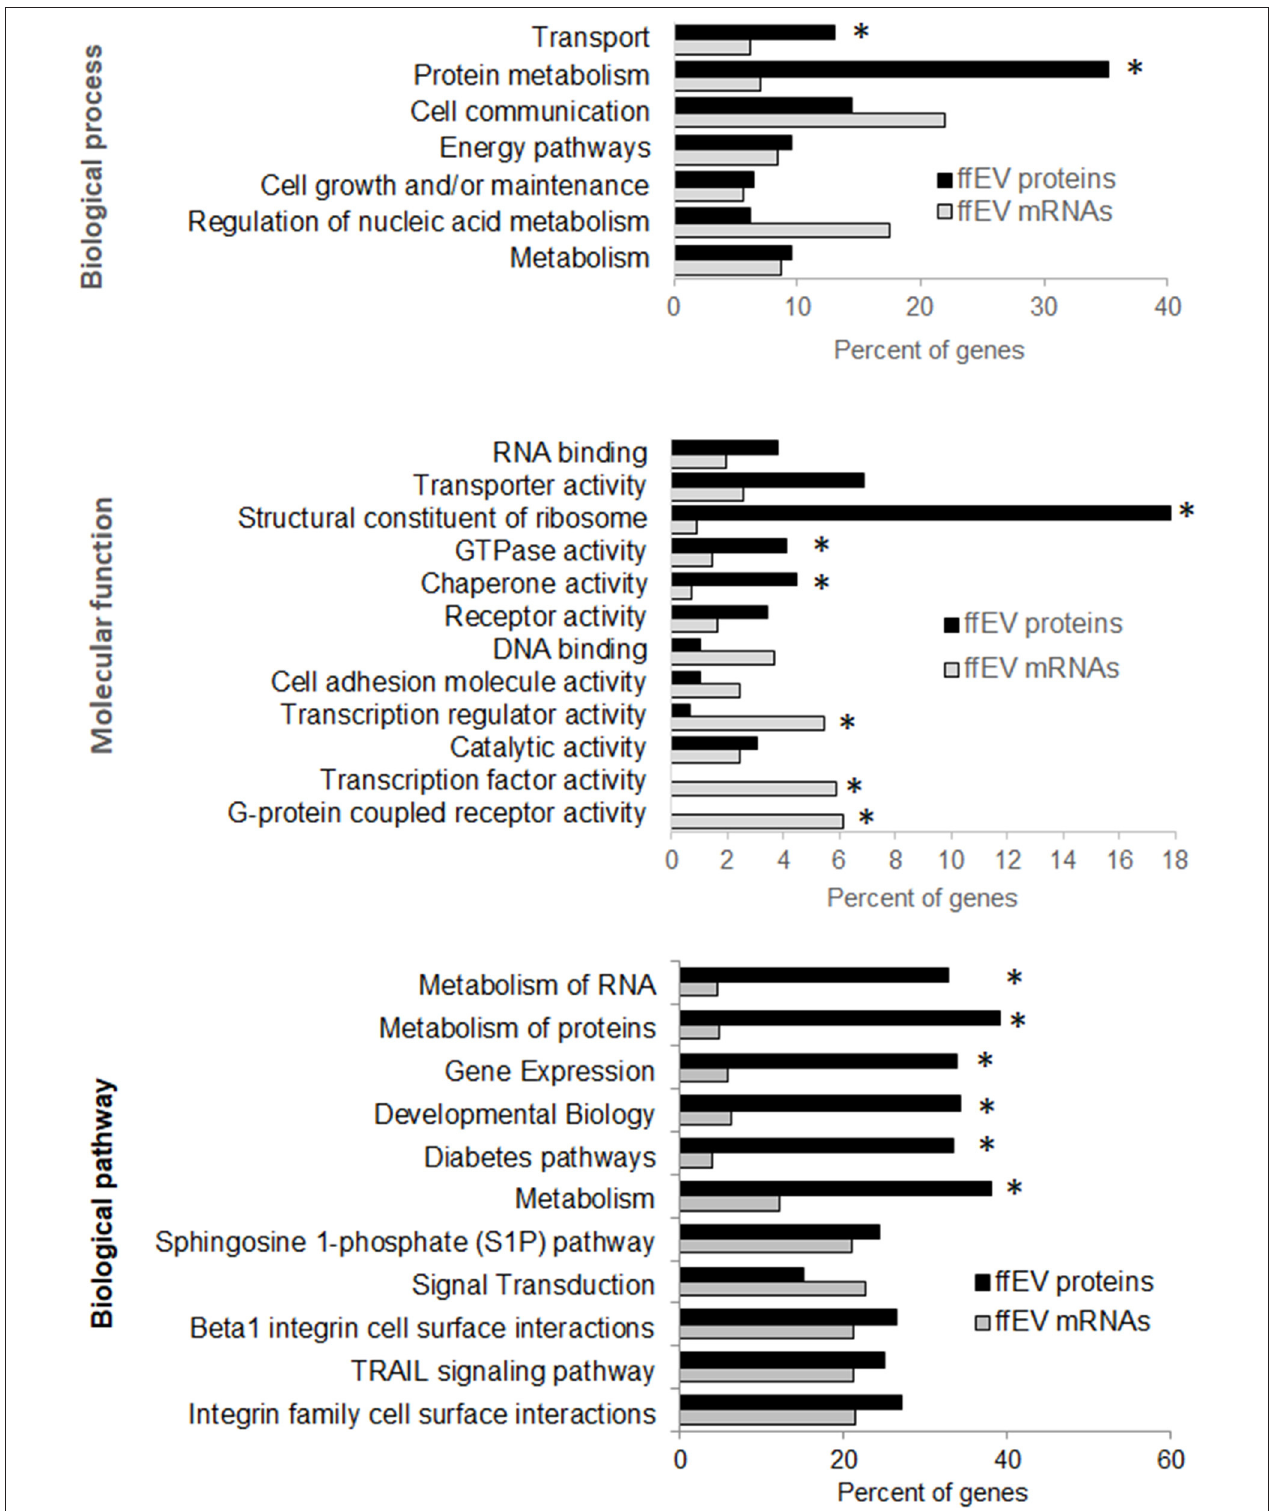
FIGURE 5 | Comparative analysis of Gene Ontology (GO) enrichment terms identified from lists of 322 proteins and 3,466 mRNAs that were identified from bovine ffEVs. Asterisks mark significant differences in GO term enrichment ( p < 0.05).